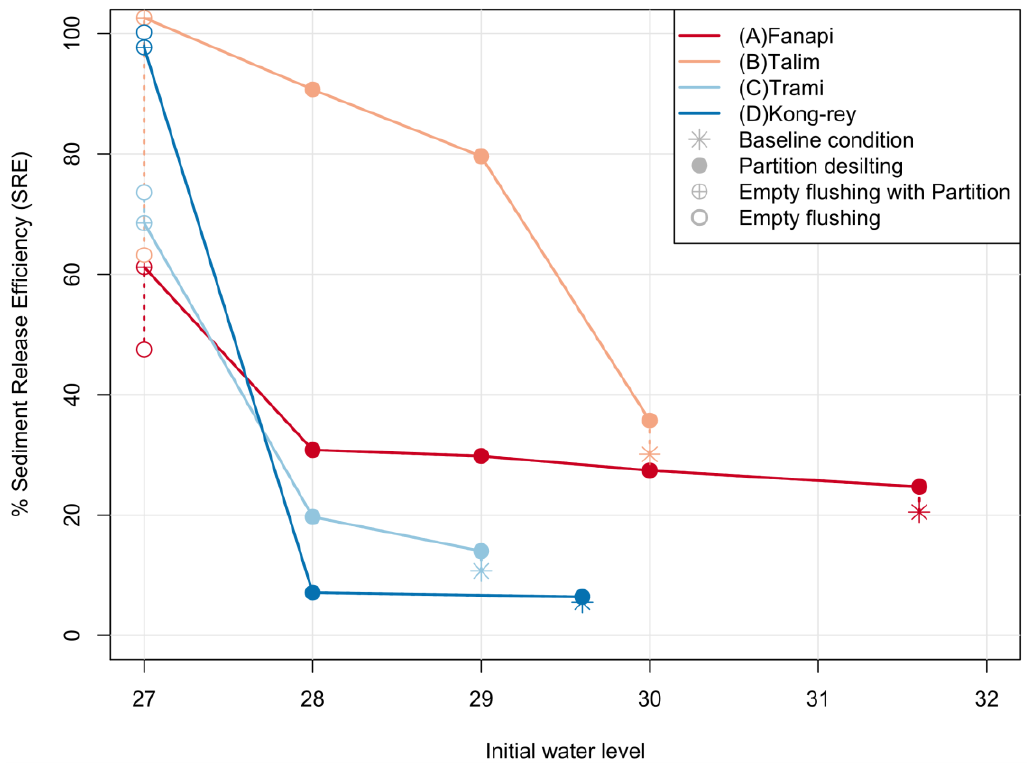
Figure 10. Differences in sediment release efficiency (SRE) based on different drawdown water level Figure 10. Di ff erences in sediment release e ffi ciency (SRE) based on di ff erent drawdown water level strategies for four typhoon strategies for four typhoon events.